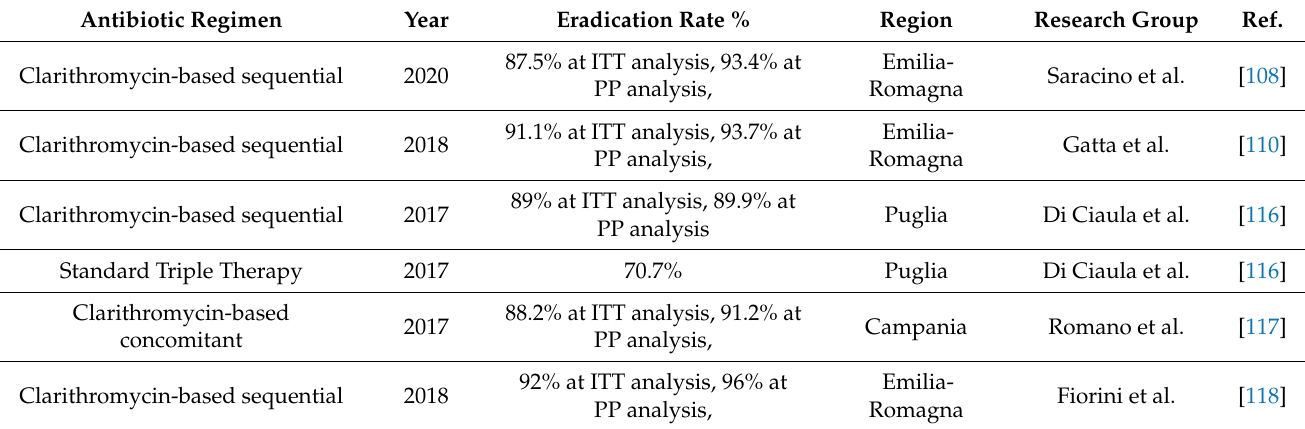
Table 9. Eradication Rate of clarithromycin-based regimens in treatment naïve patients.